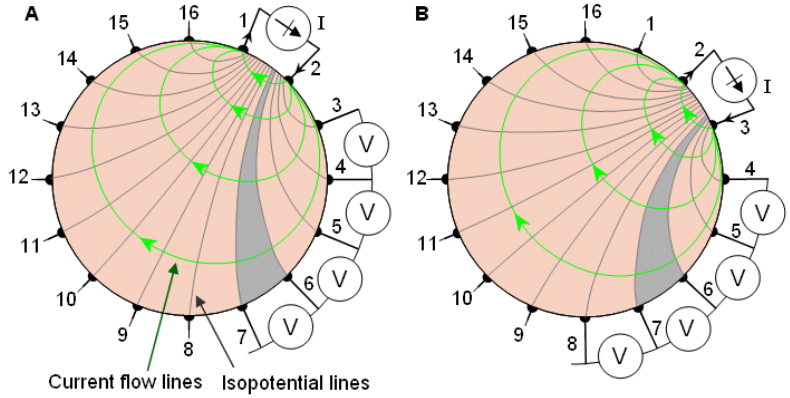
Figure 2. EIT/ERT adjacent injection and measurement protocol for the first ( A ) and second ( B ) projections (reproduced with permission from Malmivuo et al. [71]).